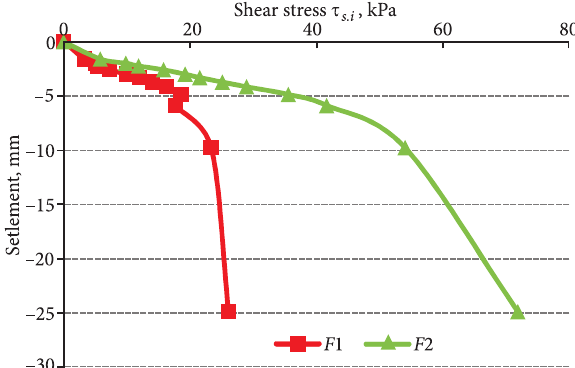
fig. 9. Load – settlement curve when the 1 st model pile was at a depth of 1.1 m